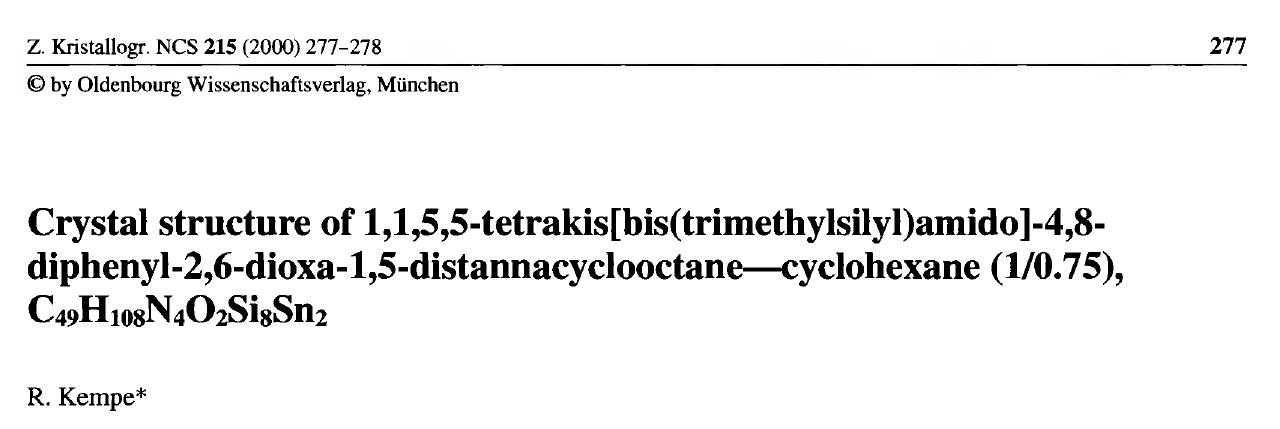
Table 1. Data collection and handling.